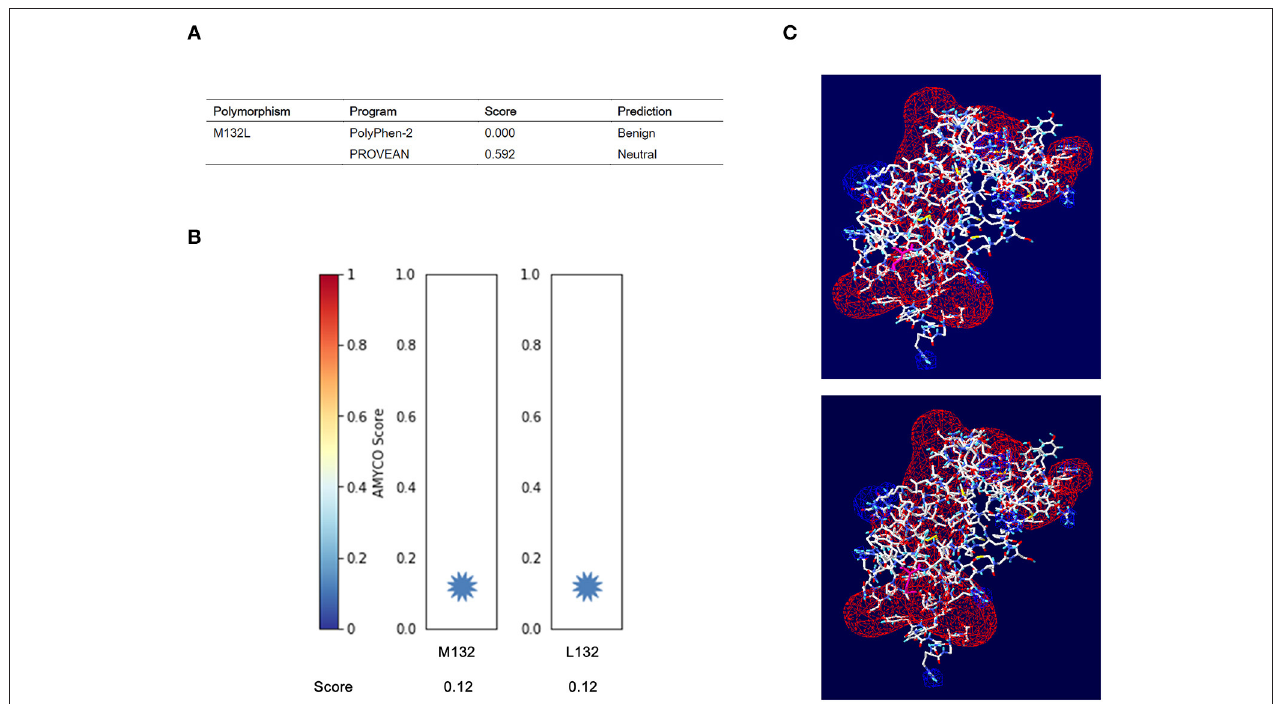
FIGURE 2 | In silico evaluation of the effect of the M132L SNP on elk prion protein (PrP). (A) Prediction of the functional effect of the M132L SNP on elk PrP by PolyPhen-2 and PROVEAN. (B) Prediction of the aggregation propensity of elk PrP according to alleles at codon 132 using AMYCO. (C) Electrostatic potential and 3D structure analysis of elk PrP according to the M132L SNP. Upper panel: electrostatic potential and 3D structure of elk PrP with the M132 allele. Lower panel: electrostatic potential and 3D structure of elk PrP with the L132 allele. Positive potentials are drawn in blue. Negative potentials are noted in